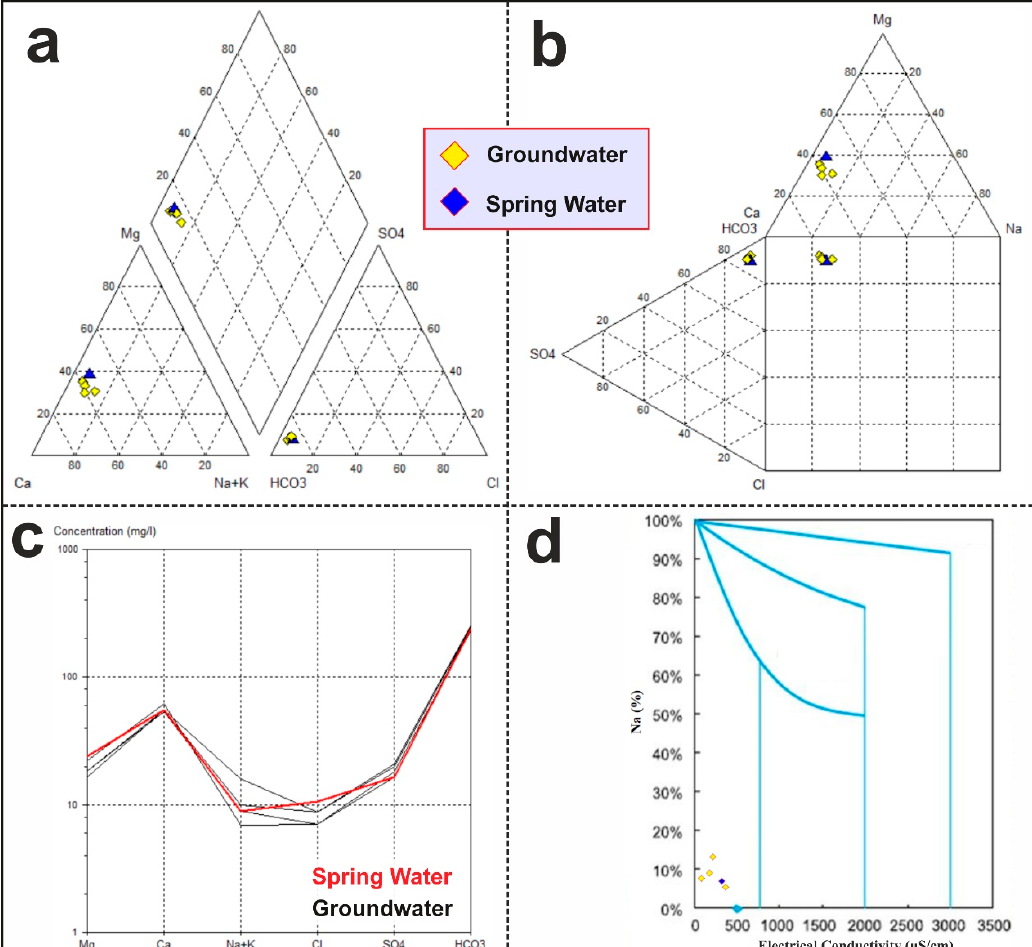
Figure 5. Representative hydrograph of Kefalovriso spring for the hydrological year 1990–1991.